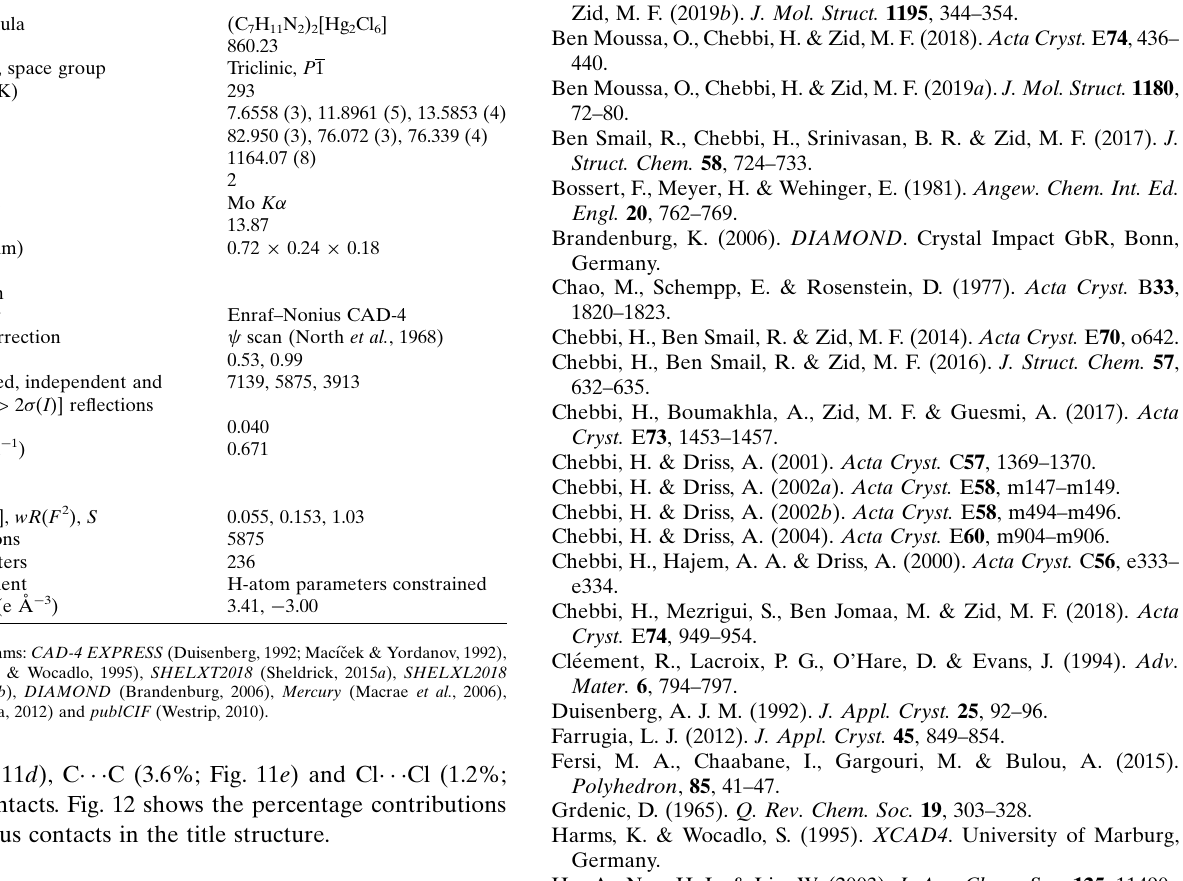
Table 2 Experimental details. Crystal data Chemical